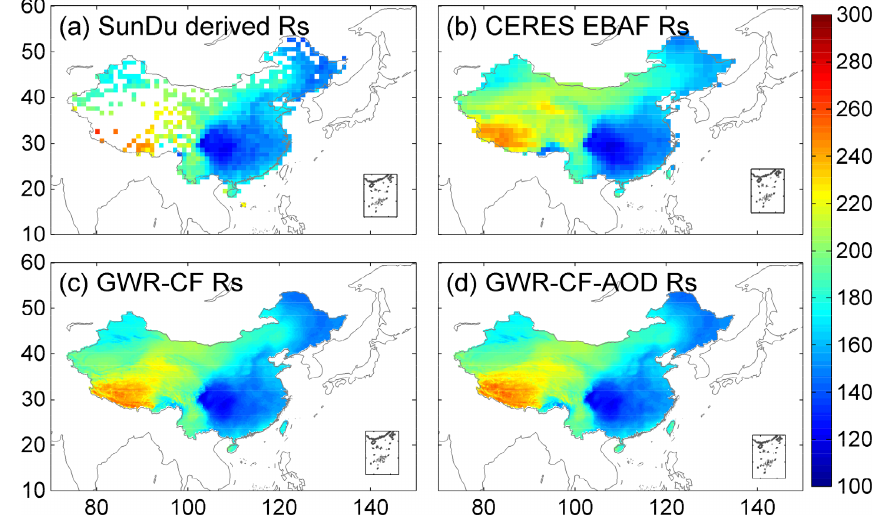
Figure 7. Spatial distribution of multiyear mean monthly surface solar radiation ( R s ) from 2000 to 2017. The first line (a, b) shows the observed multiyear mean monthly R s from SunDu and CERES EBAF; the multiyear mean monthly R s derived from the GWR method is shown in the second line (c, d) , respectively.